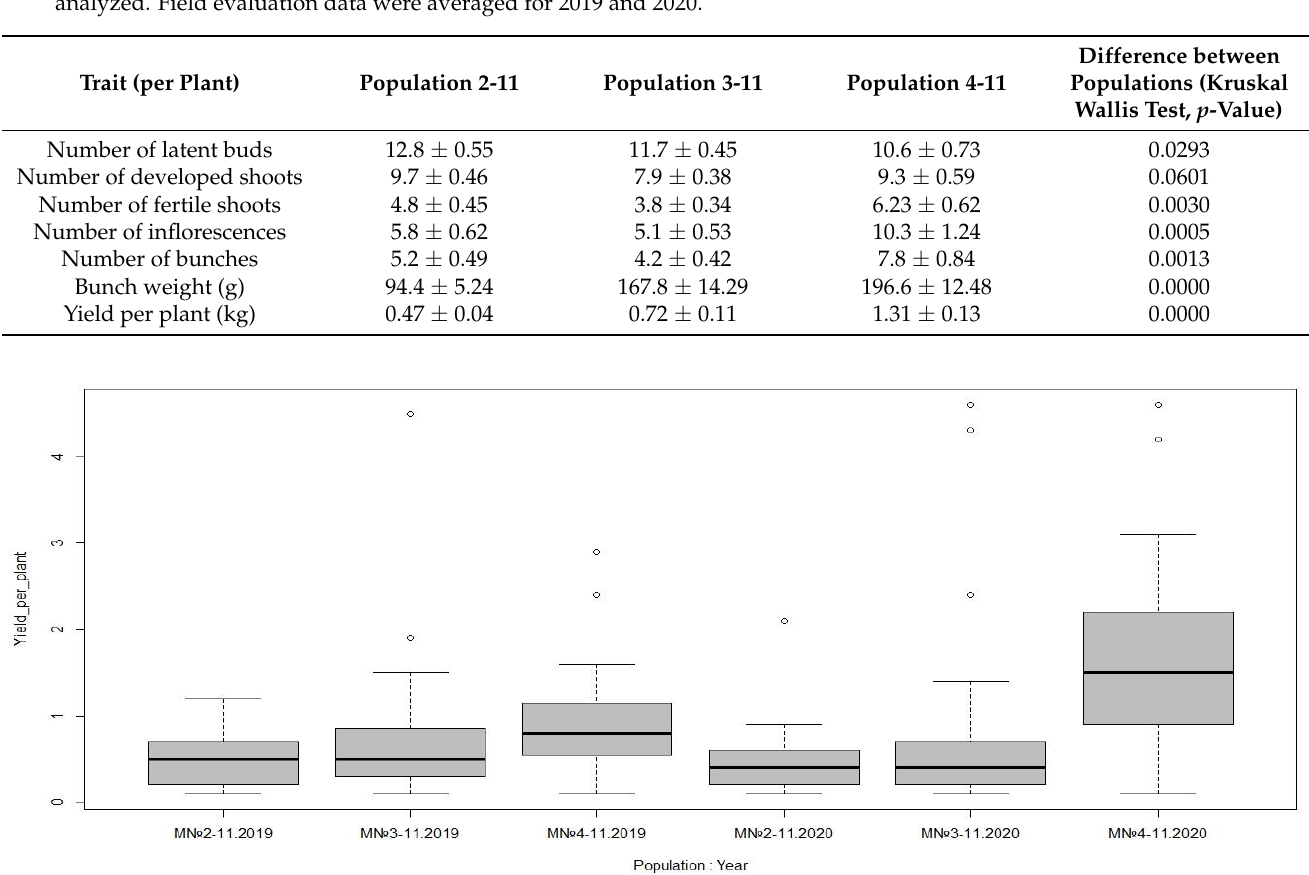
Figure 6. Boxplot of yield per plant (kg) variation between hybrid populations recorded in 2019 and 2020. Boxes indicate the interquartile range. The median for the respective data set is indicated by a horizontal line in the boxplot.